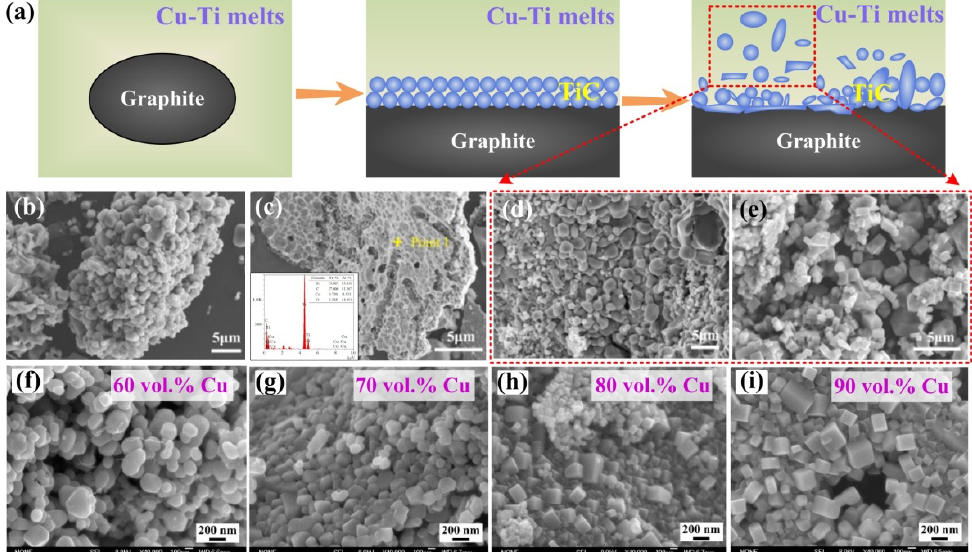
Figure 14. ( a ) the schematic diagram of the formation and separation of TiC in Cu-Ti melts. Some TiC that fails to break away from the graphite will form ( b ) TiC agglomerations or ( c ) partly integrate into larger plate-like morphologies. ( d ) Spherical and ( e ) polyhedron-like TiC particles in melts. With permission from Reference [115], copyright (2017) Elsevier.; ( f – i ) The extracted TiC particles synthesized by Cu-Ti-C system with different Cu content (from 60 vol.% to 90 vol.%).